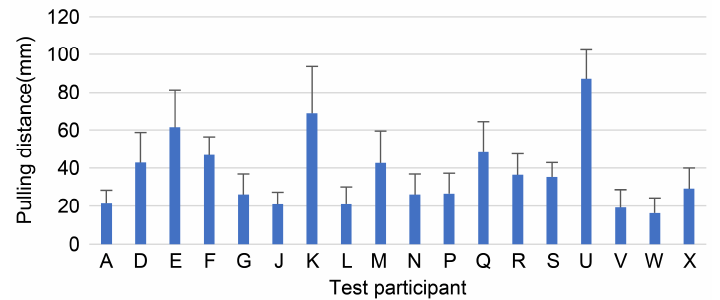
Figure 6. Results of difference between video analysis and actual measurement.